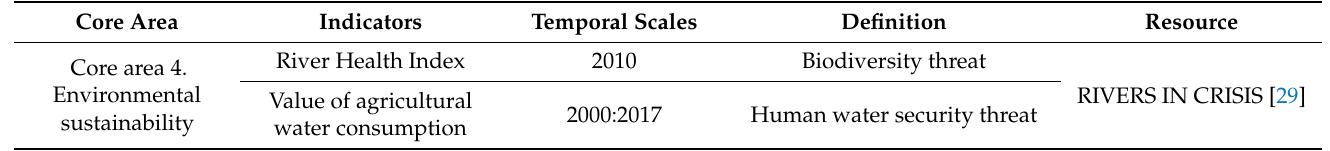
Table 4. Core area 4: indicators and variables of environmental